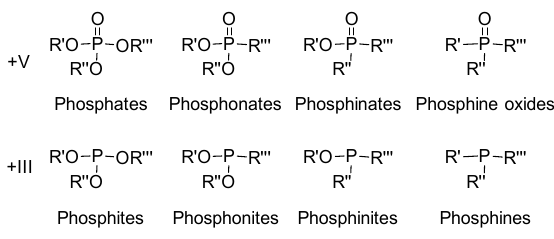
Figure 2. Overview of organo phosphorus compounds in oxidation state +V as well as their reduced analogues.